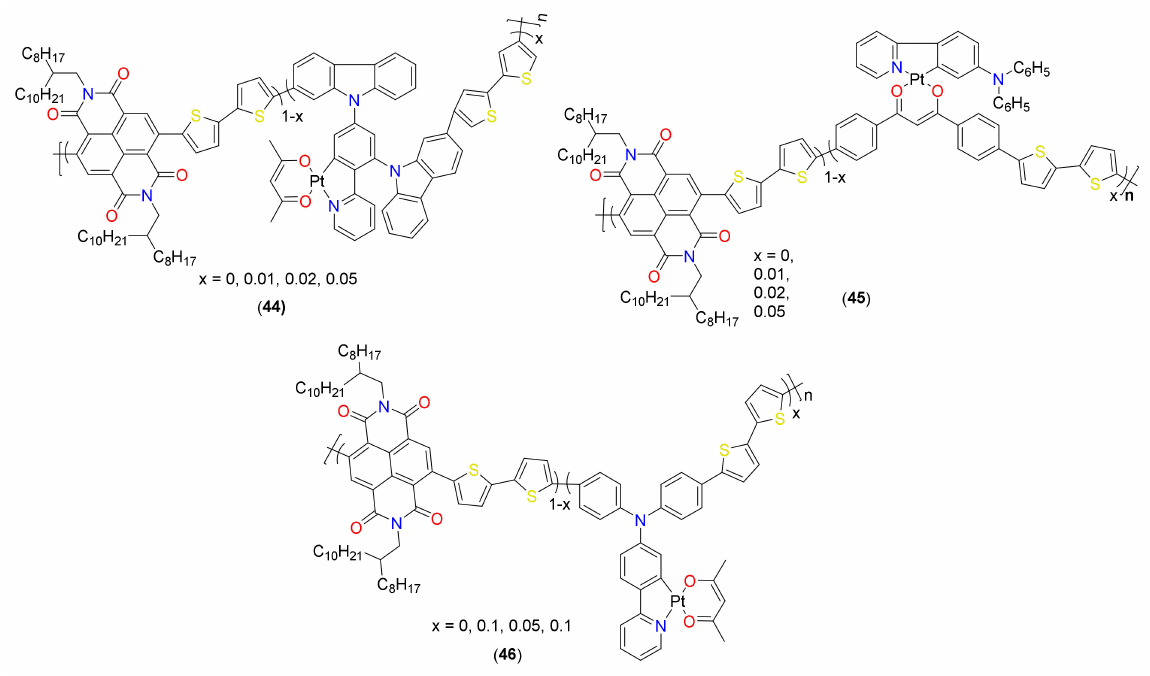
Figure 10. Cyclometalated Pt(II) complexes-based acceptor polymers for all-PSCs.